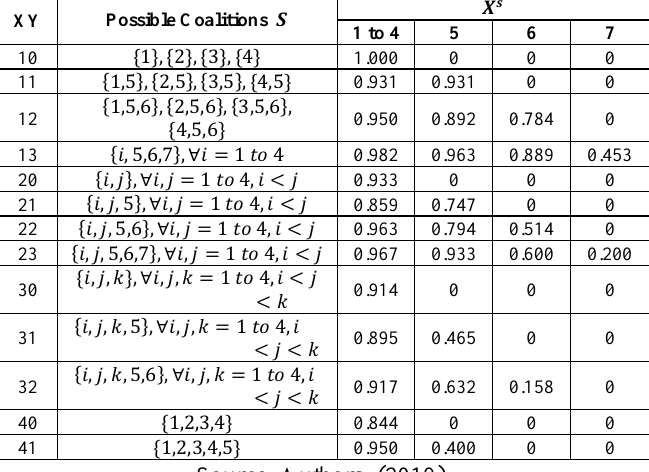
Table 4: Survival rates of the players in the existing coalitions (Standard Approach, Good